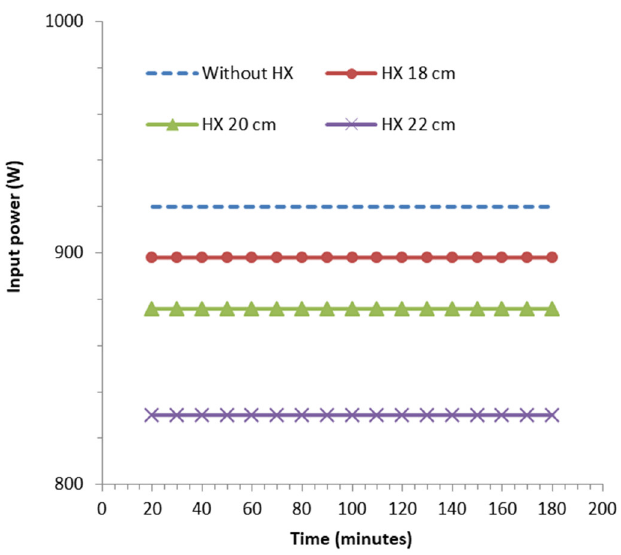
Figure 10. Variation of input power of the air conditioner for four different cases.